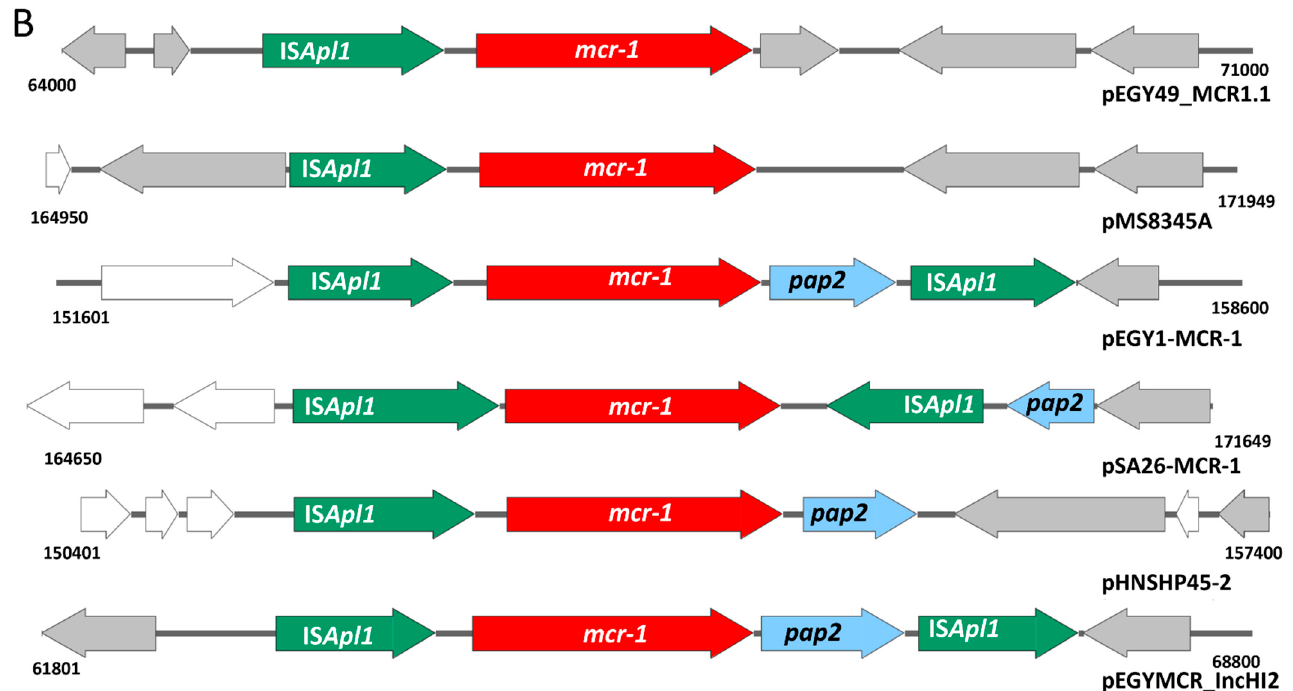
Figure 3. ( A ) BLAST Ring Image Generator (BRIG) visualization comparing IncHI2- mcr-1 -positive E. coli plasmids. The outermost ring (dark green) corresponds to pEGY49_MCR1.1 with its size indicated in the middle of the ring. Next, pMS8345A is shown (light green). The third ring corresponds to pEGY1-MCR-1 (navy blue), then pSA26-MCR1 (aqua) and pHNSHP45-2 (pink). The innermost ring (purple) refers to pEGYMCR_IncHI2. The labels in the outer ring represent the annotation of the genes associated to virulence, antibiotic resistance, stress resistance and replicons. The mcr-1 gene and IS Apl1 are marked in red and blue, respectively. ( B ) Genetic environment of mcr-1 gene in pEGY49_MCR1.1 compared to those in other IncHI2 plasmids from E. coli . The arrows indicate open reading frames ( orf ), with red, green, blue, grey and white arrows representing mcr-1 , IS Apl1 element, pap2 , ORFs with known function, and ORFs with unknown function, respectively.